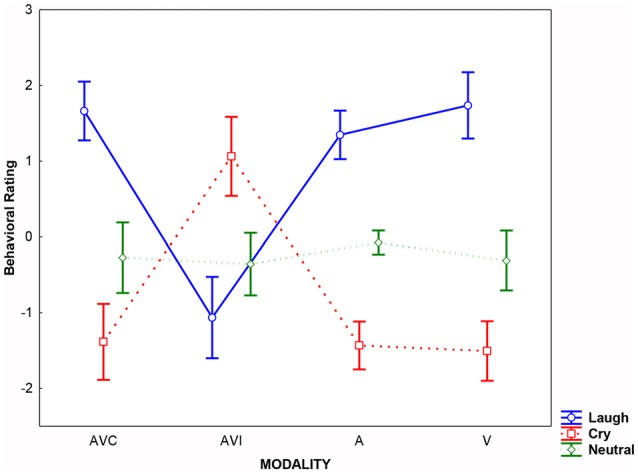
Averaged rating scores detected for each modality (AVC: Audio-Video Congruent, AVI: Audio-Video Incongruent; A: Audio, V: Video) and emotion (Laugh, Cry, Neutral). Error bars represent the standard deviation (SD).